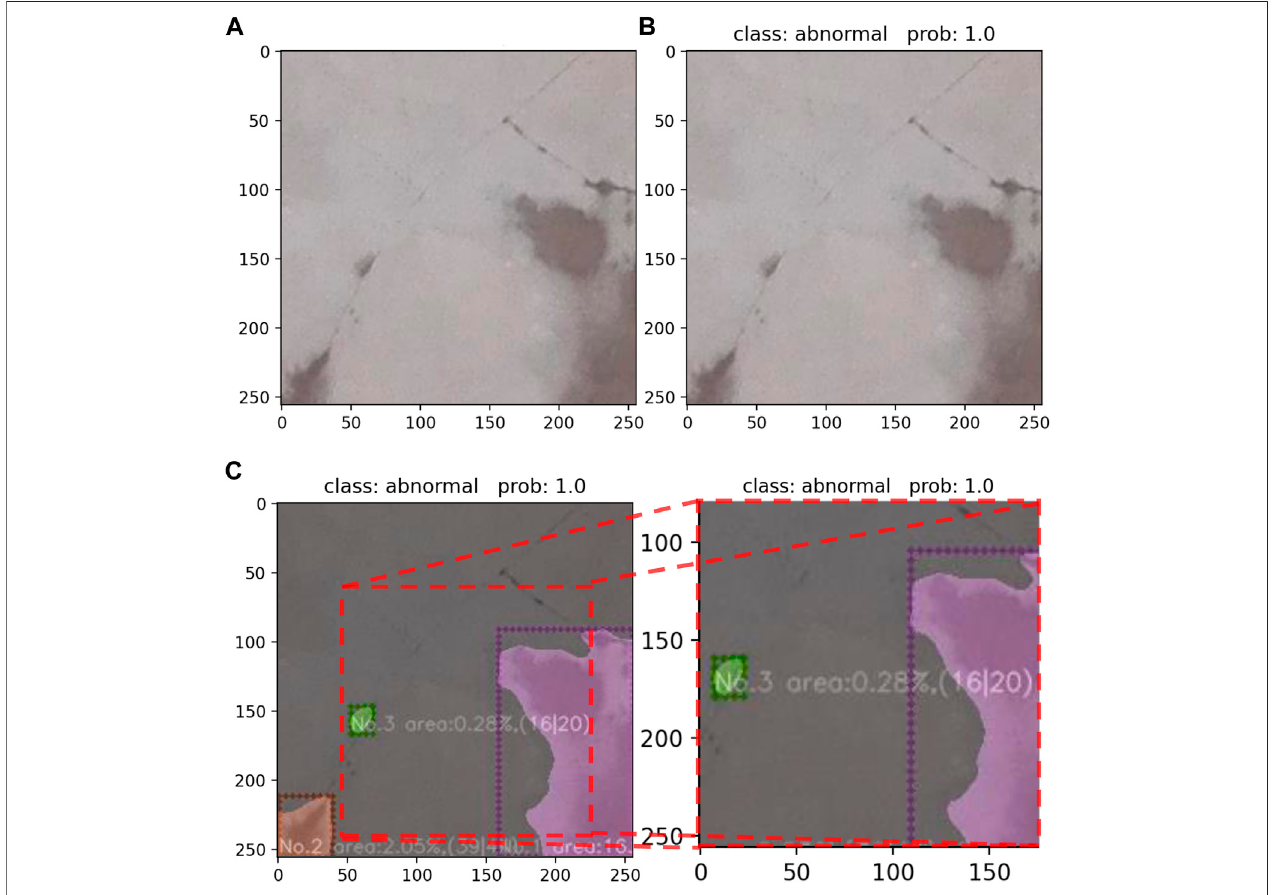
FIGURE 14 | Identi fi cation and quanti fi cation of FFC chromatic aberration experimental data: (A) Input (B) Experimental results of projection (C) Experimental results of quantitative segmentation.